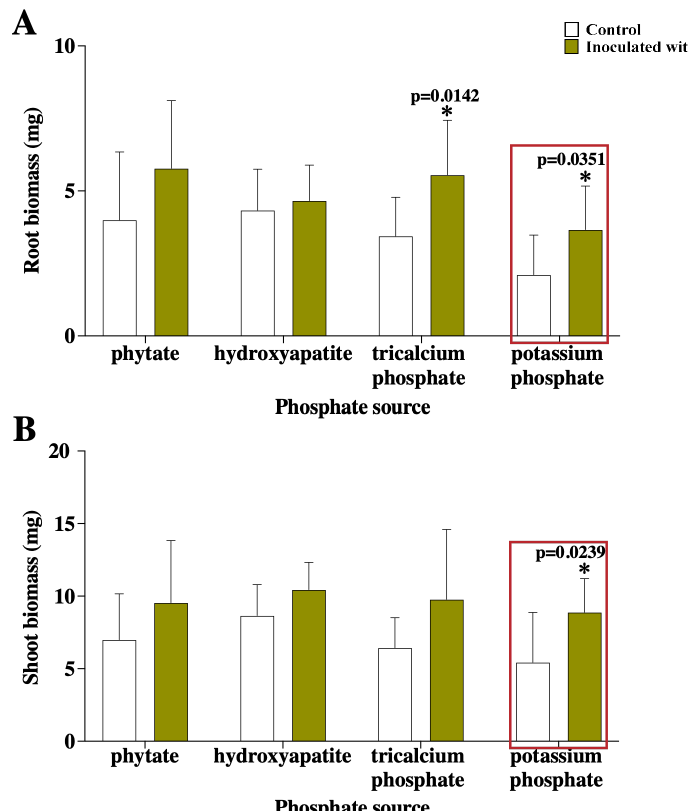
Figure 4. Growth tests of EC4-inoculated cranberry plantlets. Plants were cultivated in the greenhouse on a solid minimum mineral growth medium containing either the standard (soluble) potassium phosphate or insoluble phosphorus sources. The roots and shoots were harvested after 30 days, dried and weighed. Biomass of roots ( A ) and shoots ( B ) from plants grown on a medium containing potassium phosphate or the insoluble phytate, hydroxyapatite or tricalcium phosphate as a phosphorus source. Compared to the controls, EC4 significantly stimulates biomass accumulation in roots from plants grown on potassium phosphate ( p = 0.0351) and tricalcium phosphate ( p = 0.0142), as well as in shoots from plants grown on potassium phosphate ( p = 0.0239). Olive-green-filled bars, plants inoculated with EC4; white-filled bars, controls ‘inoculated’ with water. Whiskers represent the standard deviation, and the star indicates a statistical significance of p < 0.05.